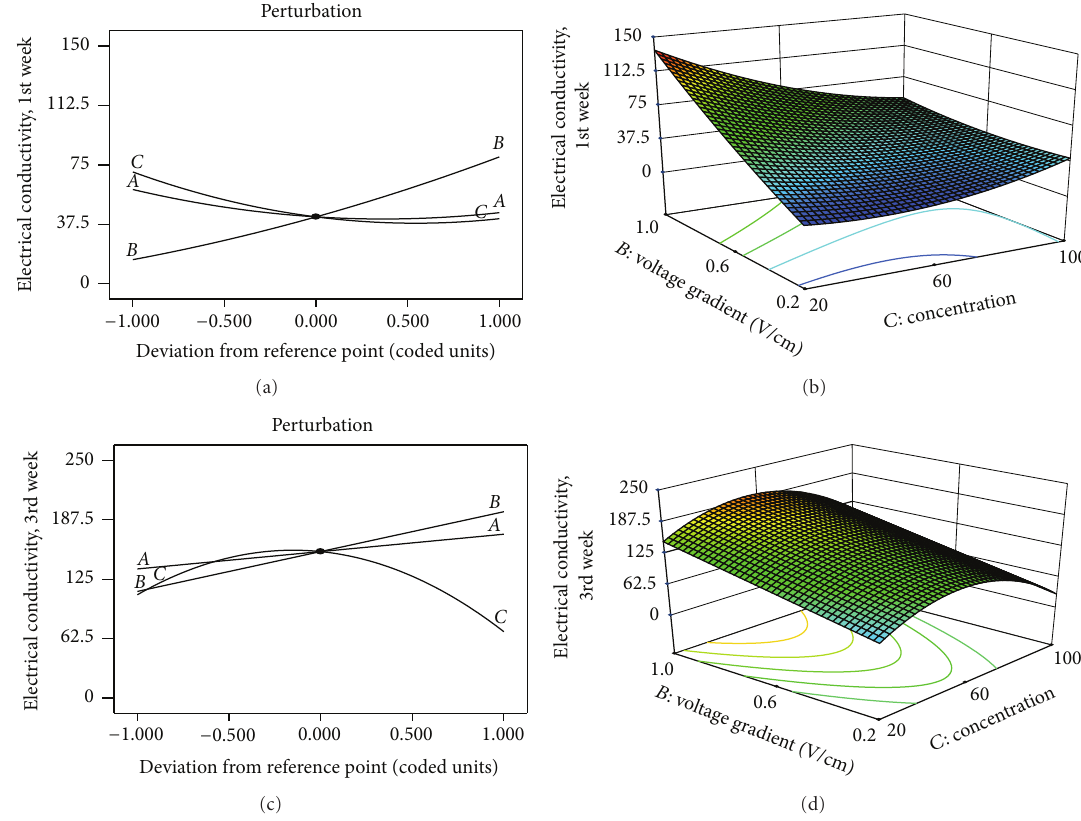
Figure 2: Perturbation plots showing the relative significance of factors on electrical conductivity (left). 3D response surface and contour plots showing the relative influence of factors on electrical conductivity (right): (a) and (b) 1st week; (c) and (d) 3rd week.